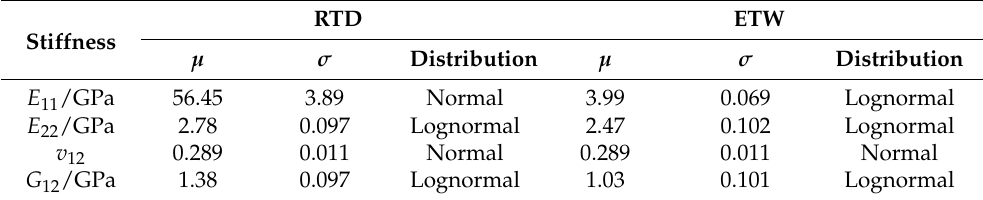
Table 20. Comparison of the probability distribution characteristics of the stiffness properties of